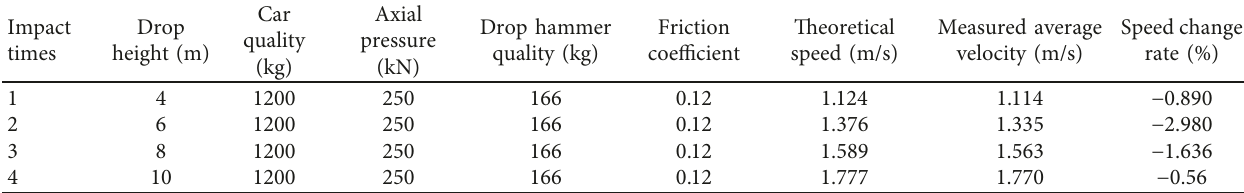
Table 3: Impact scheme 1.